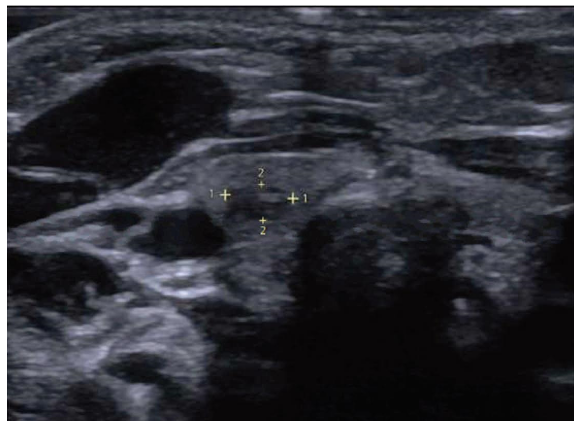
Figure 1: Ultrasound of the neck demonstrating 3.7 × 2.0 × 3.1mm nodule in the right thyroid lobe.